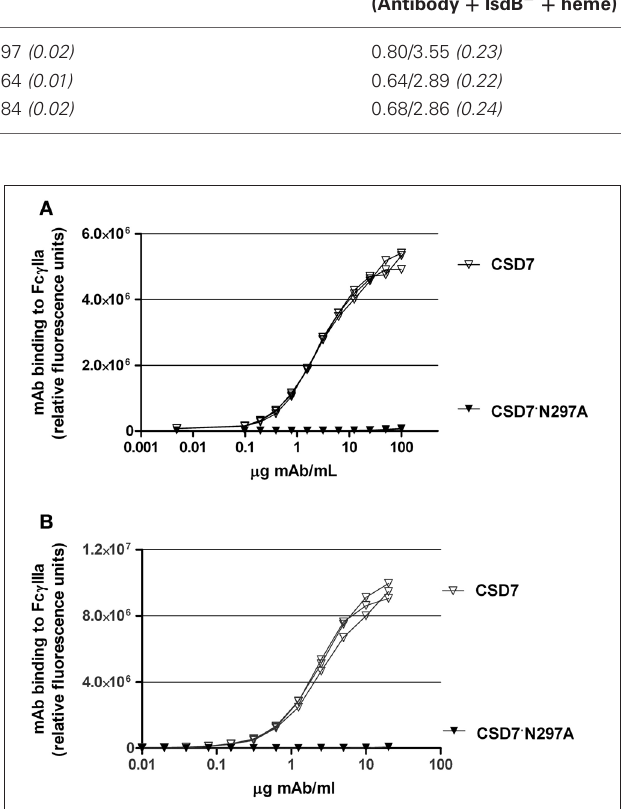
FIGURE 2 | CS-D7 or CS-D7 · N297A mAb binding to Fc γ RIIa or Fc γ RIIIa. Binding of mAbs to (A) Fc γ IIa or (B) Fc γ IIIa was measured as described in Methods. Data shown are individual curves for triplet